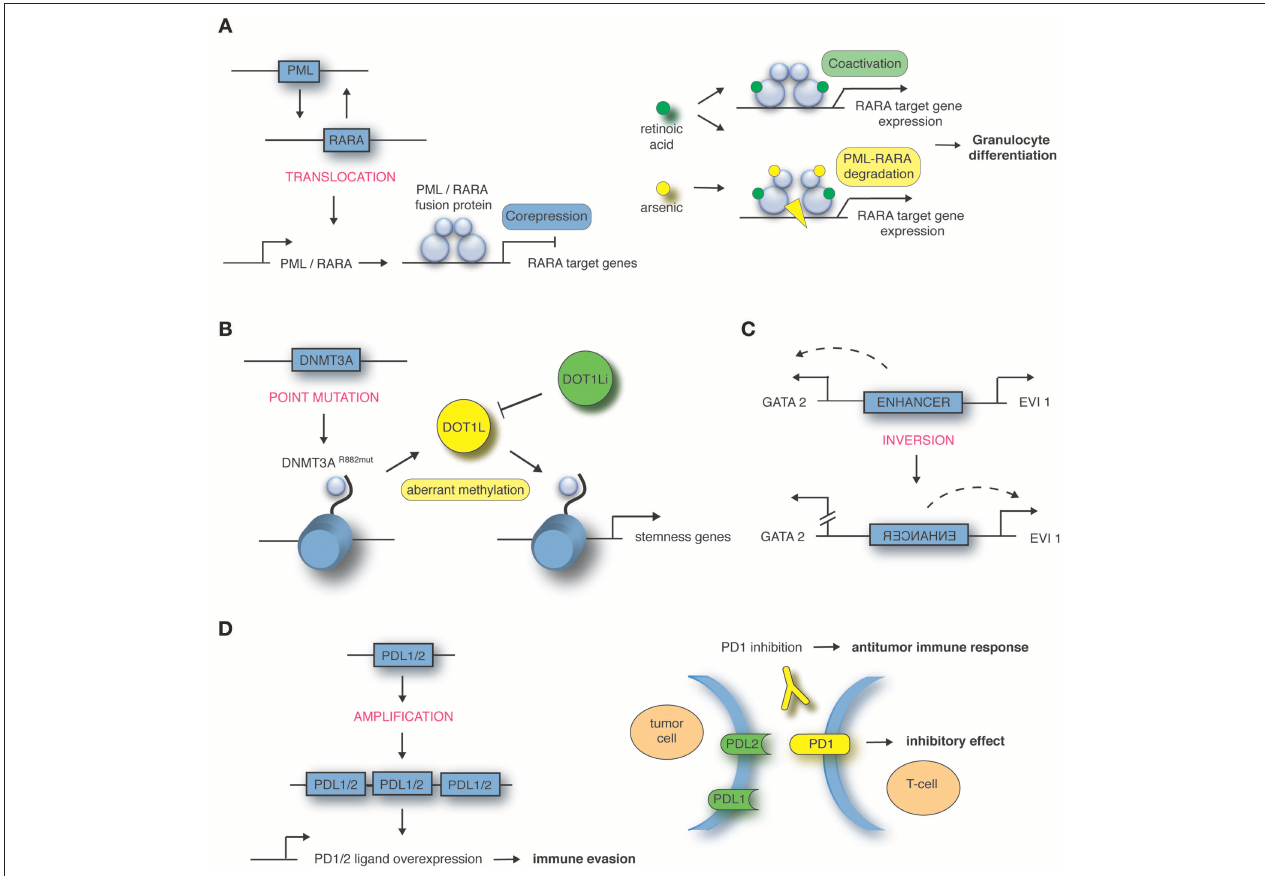
FIGURE 1 | Mechanisms of structural variations in hematological malignancies. (A) Translocation t(15;17) encoding the PML-RARA fusion in APL, targeted by all-trans retinoic acid (ATRA) in combination with arsenic trioxide (ATO). Adapted from de Thé et al. (16). (B) Point mutation in DNMT3A gene locus in AML leads to aberrant methylation and recruitment of DOT1L, targeted by DOT1L inhibitor (DOT1Li). Adapted from Lu et al. (17) and Lu and Wang (18). (C) Inversion inv(3) encoding an enhancer in AML. Adapted from Bhagwat et al. (19). (D) Amplification of 9p24 in Hodgkin’s lymphoma leads to PDL1/PDL2 overexpression, targeted by PD1 inhibitor. Adapted from Goodman et al. (